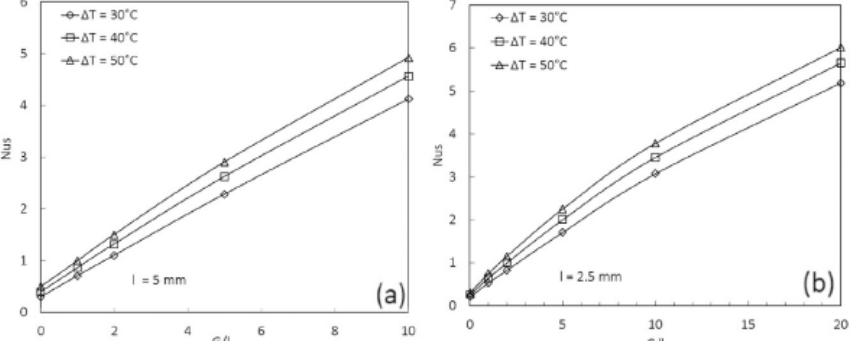
Figure 4: Graphical presentation of Effect of interruption length on the Nusselt number for natural convection heat transfer from the fins, (numerical results), a) fin length l =12.5 mm, b) fin length l = 2.5 mm [38]